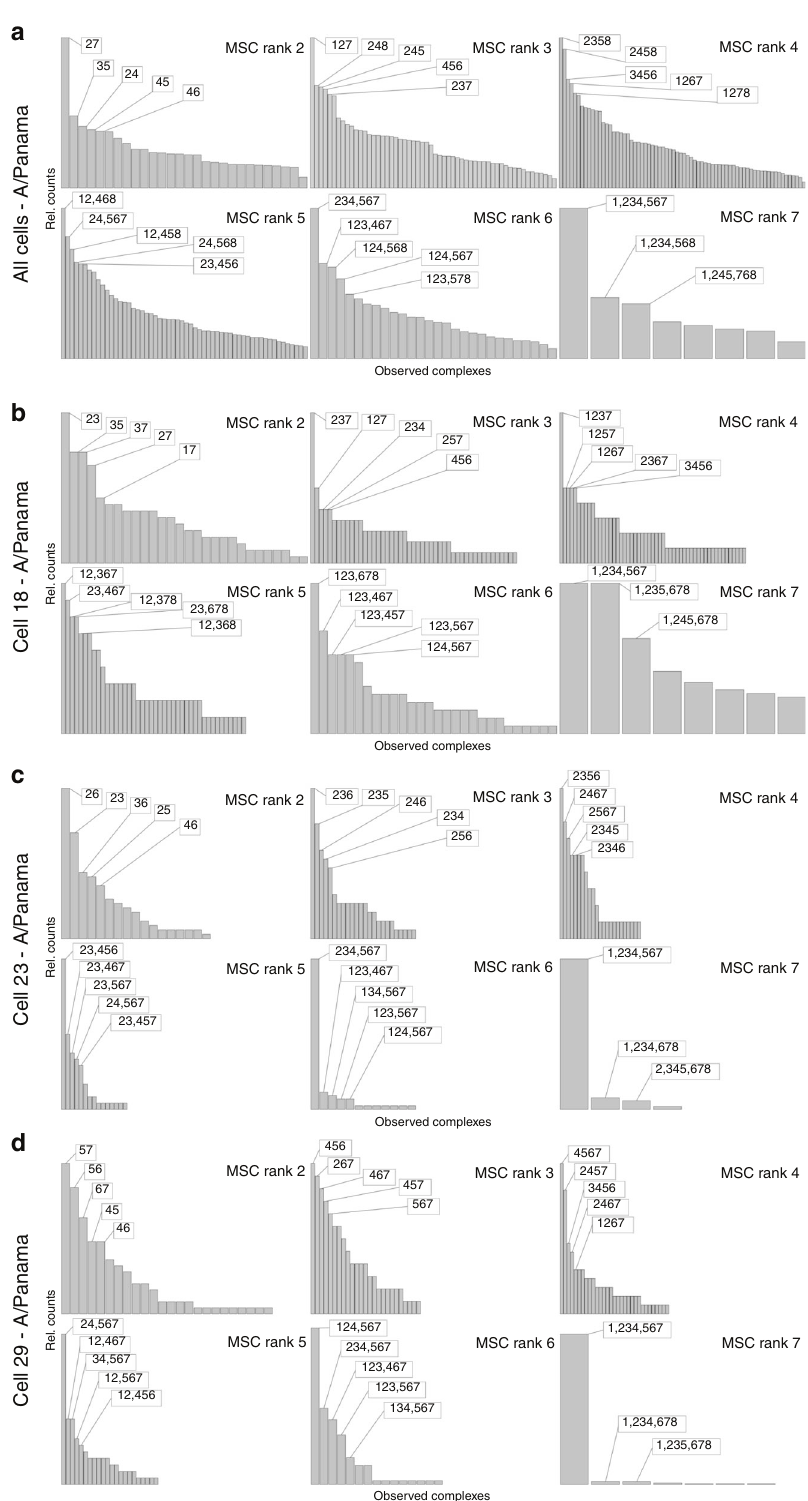
Fig. 4 Speci fi c segment combinations at intermediate MSC ranks after 10 h.p.i. Each subplot shows the total relative counts of MSCs of each rank containing speci fi c combinations of segments for all of the 69 analysed cells ('All Cells' a ) and exemplary single cells ( ‘ Cells 18, 23 and 29 ’ b – d , see also Fig. 3). Listed are the compositions of segments of the fi ve most abundant complexes of each complex rank (boxes). To relate frequencies to the total counts of the MSCs of the speci fi c rank we refer to Fig. 3 (left column). For better visualisation, data are normalised to the most abundant MSC of the respective rank. Source data are provided as a Source Data fi